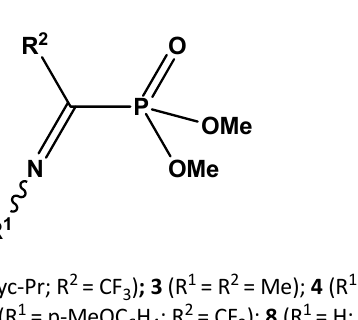
Figure 2. Calculated iminophosphonates 1–10 .